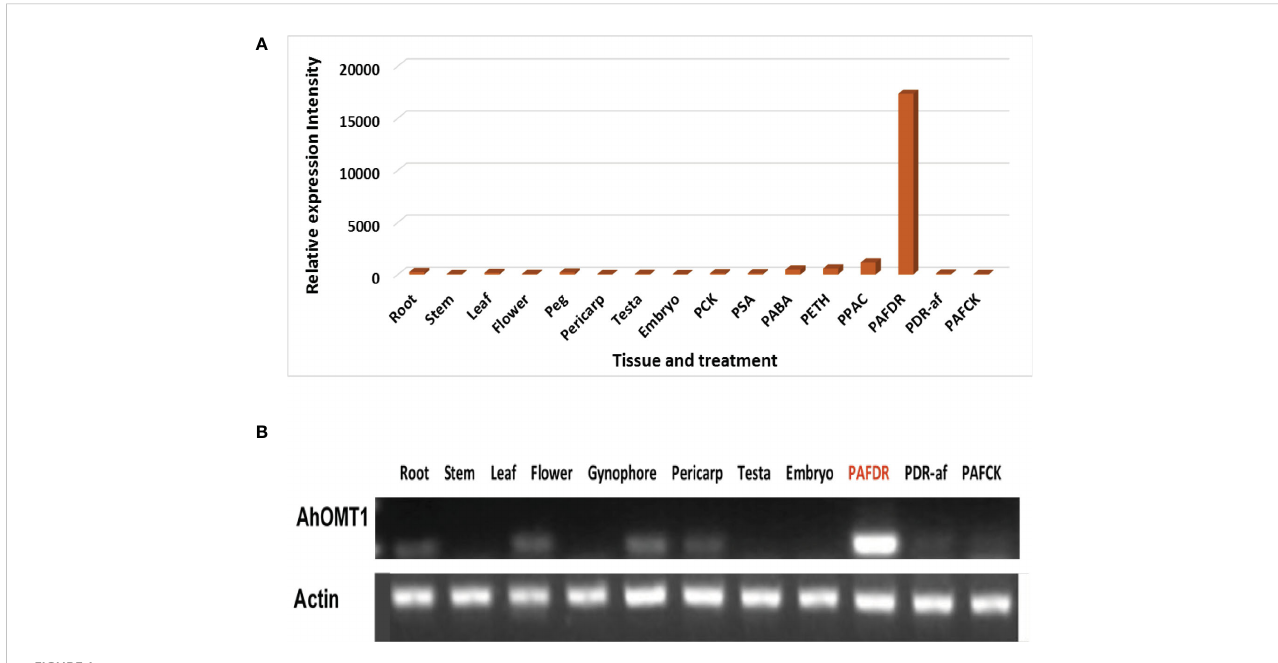
FIGURE 1 A. fl avus inducible gene screening and AhOMT1 expression in peanut. (A, B) AhOMT1 gene showed very week or no expression in different tissues (root, stem, leaf, fl ower, pericarp, testa, and embryo), but gigantic upregulation induced by A. fl avus by both microarray and RT-PCR analysis. The DNA template from the pericarp treated with drought (PDR-af), drought plus Aspergillus fl avus infection (PAFDR), and normal watering (PAFCK).